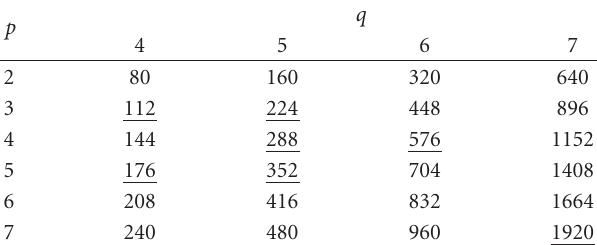
Table 1: A selection of the FFTs that can be generated with the PFA mapping. FFTs used in DRM are